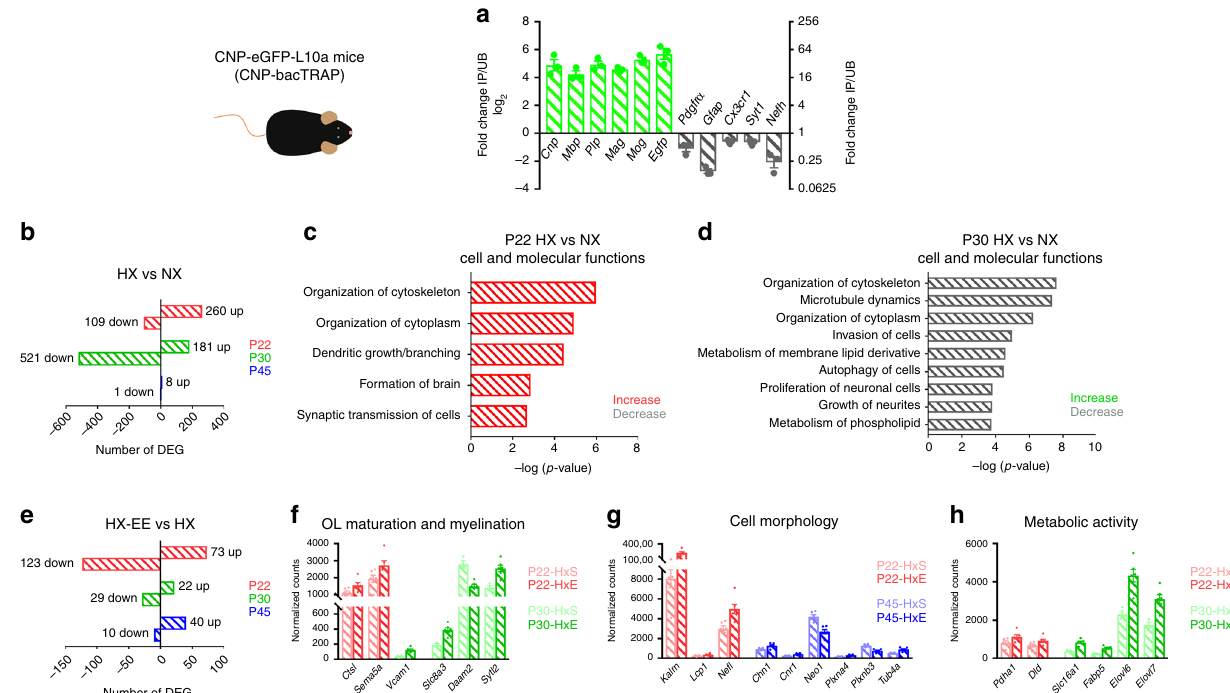
Fig. 9 RNA-seq reveals EE-induced changes in oligodendrocyte translatome following perinatal hypoxia. a qRT-PCR analysis of immunoprecipitated (IP) and unbound (UB) fractions from the white matter of CNP-bacTRAP mice. Green bars correspond to genes enriched in OLs, and grayscale bars correspond to genes enriched in other cell types. Bars represent mean ± SEM ( n = 3 per group). Cnp , myelin basic protein ( Mbp ), proteolipid protein (Plp), myelin- associated glycoprotein ( Mag ), myelin oligodendrocyte glycoprotein ( Mog ), enhanced green fl uorescent protein ( Egfp ), platelet-derived growth factor receptor alpha ( Pdgfr α ), glial fi brillary acidic protein ( Gfap ; astrocytes), fractalkine receptor ( Cx3cr1 ; microglia), synaptotagmin-1 ( Syt1 ; neurons), and neuro fi lament-heavy ( Nefh ; axons). b Number of DEGs between HX and NX mice at P22, P30 and P45 (Wald test with Benjamini − Hochberg post hoc, adjusted p < 0.05, normalized counts > 5) (P22: HX, n = 6, NX, n = 4; P30: HX, n = 3, NX, n = 5; P45: HX, n = 6, NX, n = 5). c , d Predicted increases (colored) and decreases (gray) in cell and molecular functions (determined by directional z -scores) in HX compared to NX at P22 ( c ), and P30 ( d ). Cell and molecular functions ranked based on p value as determined using Fisher ’ s Exact Test. e Number of DEGs between HX-EE and HX mice at P22, P30 and P45 (Wald test with Benjamini − Hochberg post hoc, adjusted p < 0.05, normalized counts > 5) (P22: n = 6 per group; P30: HX-EE, n = 6, HX, n = 3; P45: n = 6 per group). f – h Normalized counts of a selection of signi fi cant genes (Wald test with Benjamini − Hochberg post hoc, adjusted p < 0.05) involved in OL maturation and myelination ( f) , cell morphology ( g ), and metabolic activity ( h ) compared between HX-EE and HX at P22 (red), P30 (green), and P45 (blue) (P22: n = 6 per group; P30: HX-EE, n = 6, HX, n = 3; P45: n = 6 per group). Bars represent mean ± SEM. Source data are provided as a Source Data fi